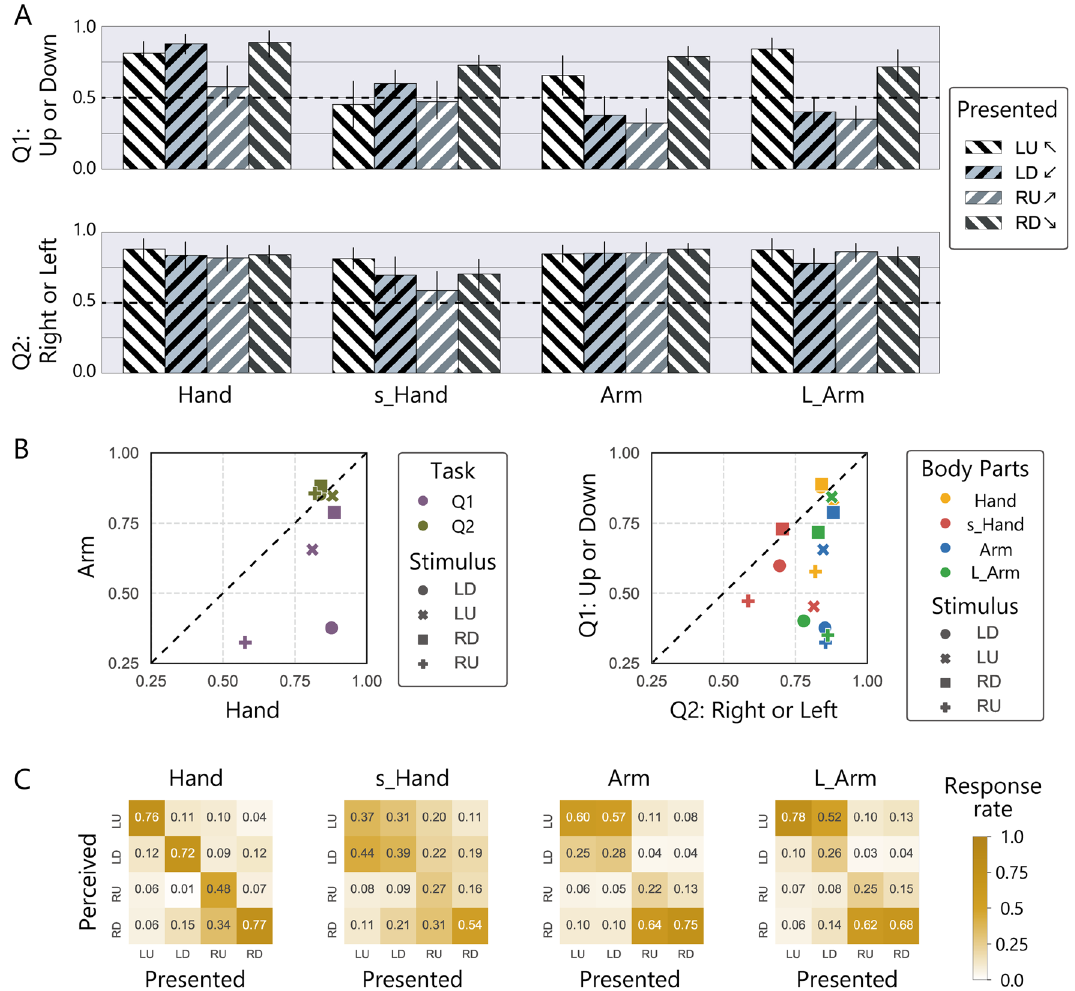
Figure 2. Results of Experiment 1. ( A ) Averaged correct rates for each 2-AFC reported by 12 participants. Error bars represent 95% confidence intervals (CIs). ( B ) Left panel represents the performance relationship between the hand and arm conditions. The vertical axis represents the averaged correct rate for the arm condition, and the horizontal axis represents that for the hand condition. The right panel represents the performance relationship between the two 2-AFCs. The vertical axis represents the averaged correct rate for the vertical 2-AFC, and the horizontal axis represents that for the horizontal 2-AFC. ( C ) The average rate of the perceived direction, estimated from the results of Q1 and Q2. In the confusion matrices, each column represents the presented direction of the stimuli and each row represents the reported direction. Diagonal lines represent correct